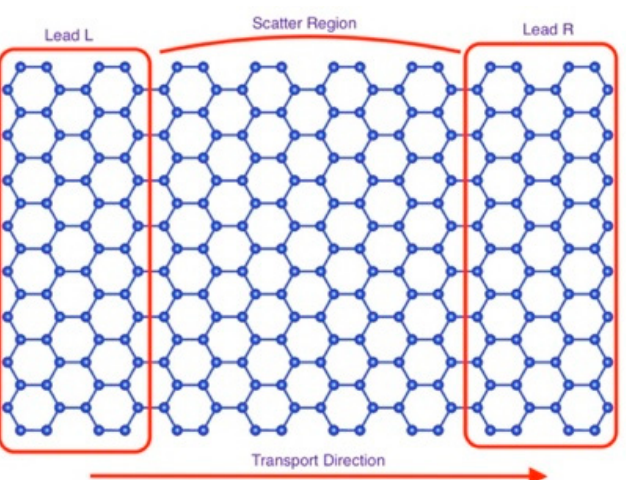
Figure 2. The sketch of the suggested silicene/germanene biosensor for DNA/RNA sequencing. The transmission can be obtained via the Green’s functions for this system T ( E ) = Γ L ( E , V ) G ( E , V ) Γ R ( E , V ) G † ( E , V ) (cid:104) (cid:105) Σ − Σ † where the coupling matrices are given by Γ α = i with α ≡ { L , R } . Σ L / R are the α α self-energies of the semi-infinite electrodes and G ( E , V ) = [ E x S − H [ ρ ] − Σ ( E , V ) − Σ ( E , V )] − s s L R